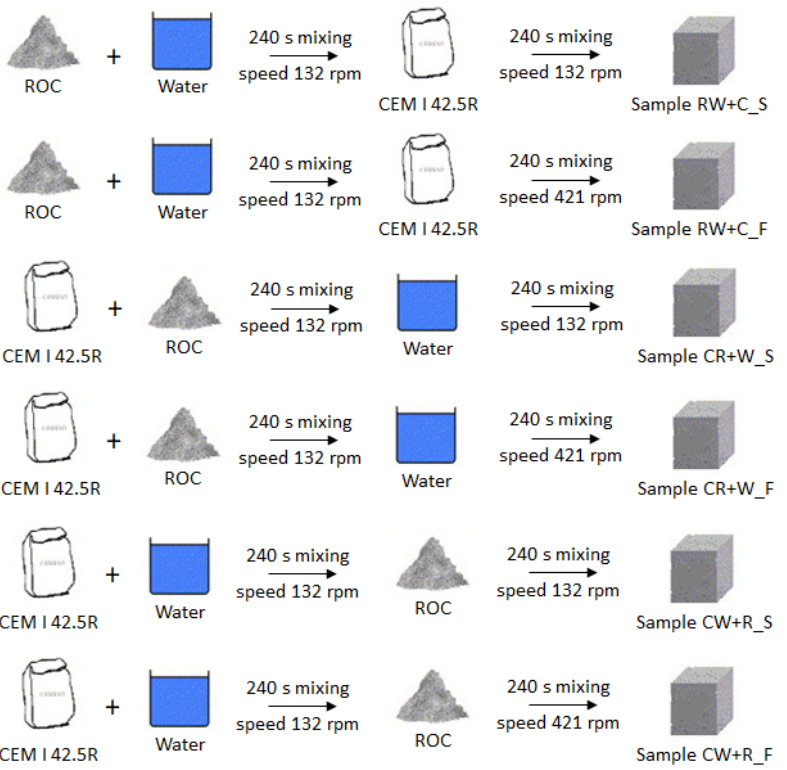
Figure 1. Approach of mixing fresh